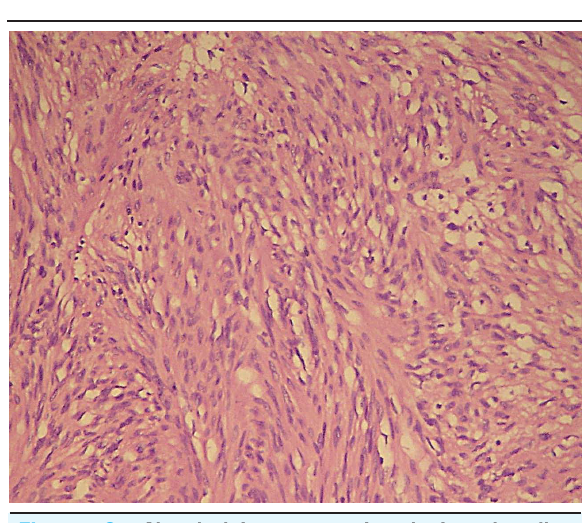
figure 3. nasal leiomyoma: Interlacing bundles of smooth muscles cells with oval to elongated nuclei.(H&e,